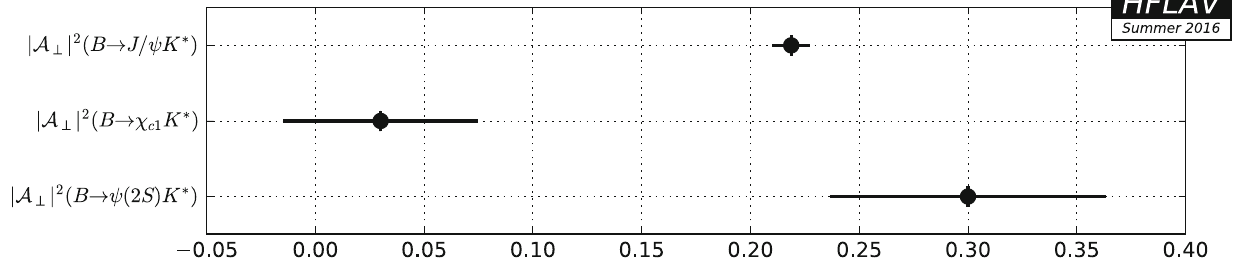
Fig. 147 Summary of the averages from Table 181